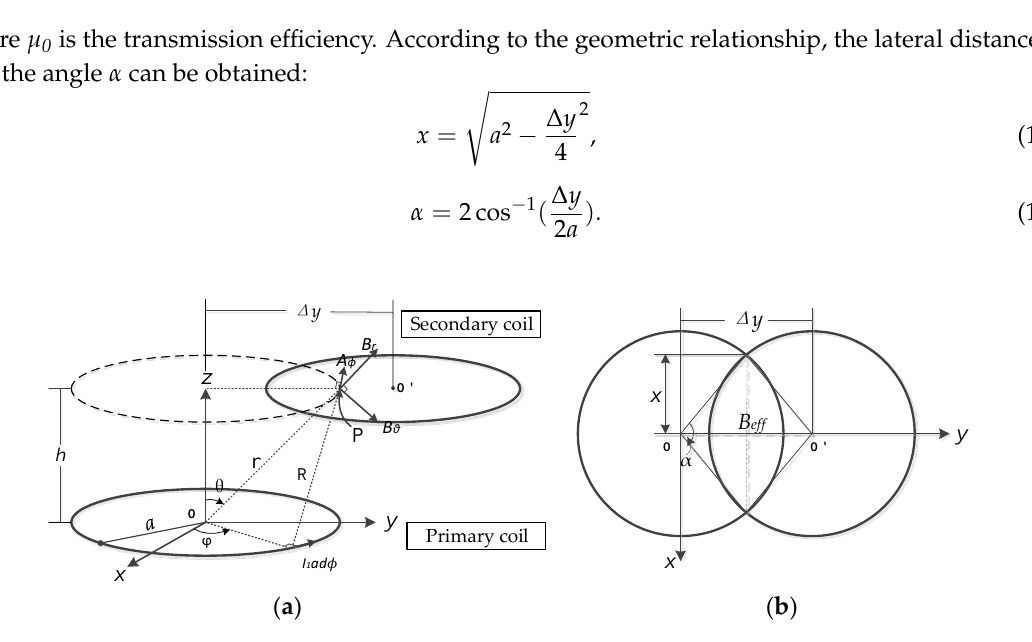
Figure 5. Offset diagram: ( a ) coordinate view; ( b ) top view.